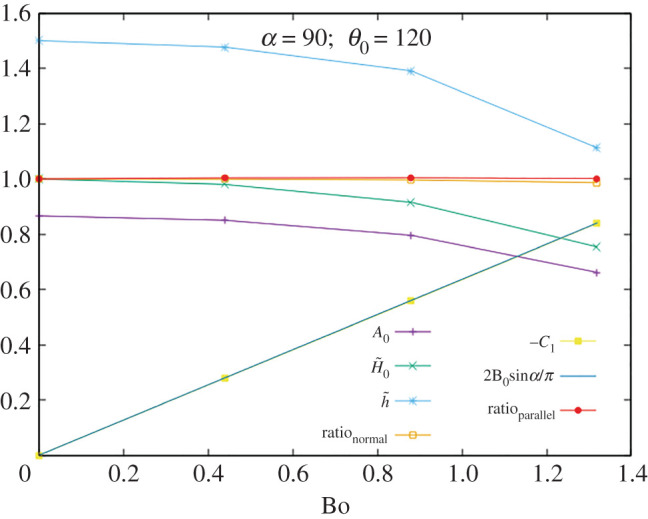
Testing the identities for α = 90° and θ0 = 120°.